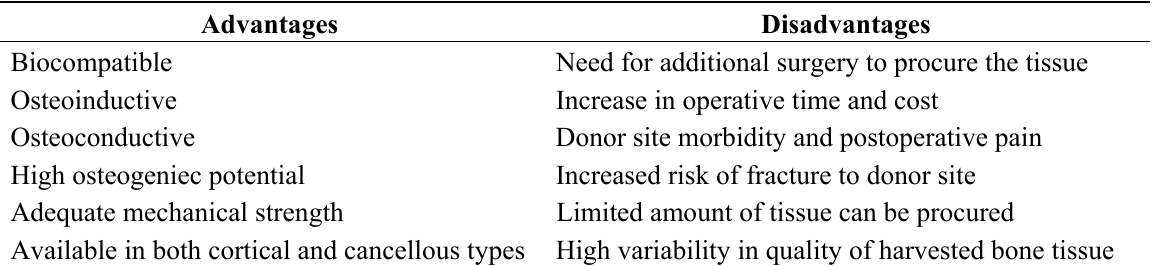
Table 2. Advantages and disadvantages of using autografts for bone